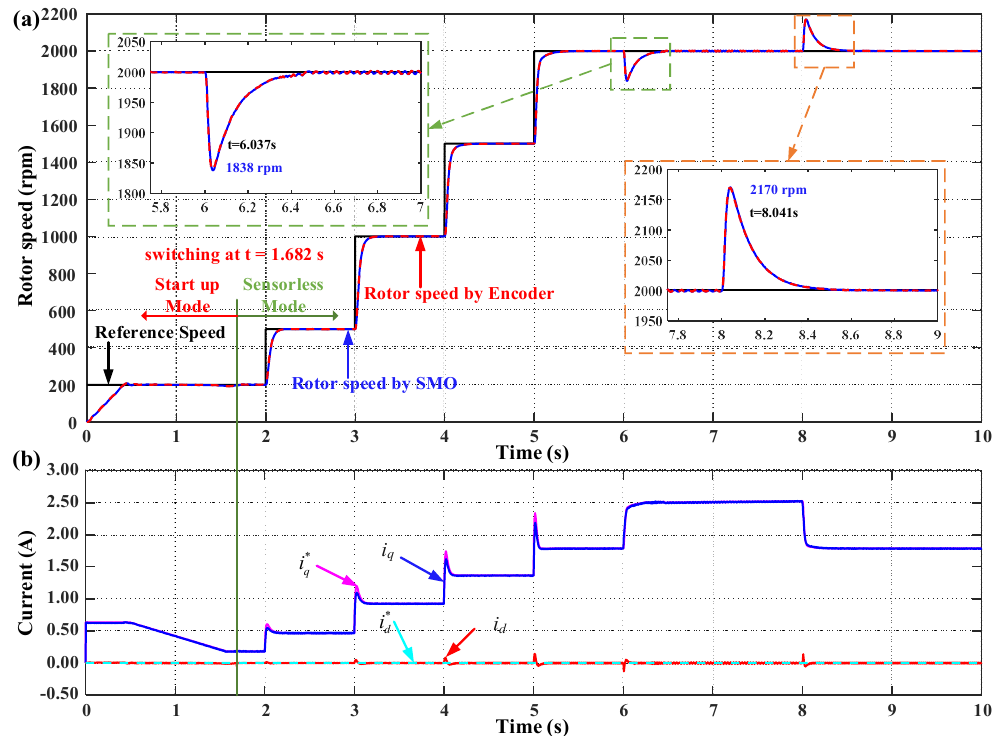
Figure 11. Simulation results in the case of the varied external load ( R L = 100 ↔ 50 Ω) at 2000 rpm for ( a ) speed response, ( b ) current response.